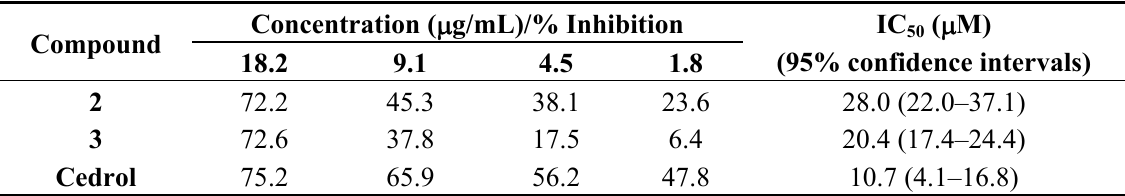
Table 2. Inhibitory effects of compound 2 and 3 on the PAF receptor binding to rabbit platelets at various concentrations and their IC 50